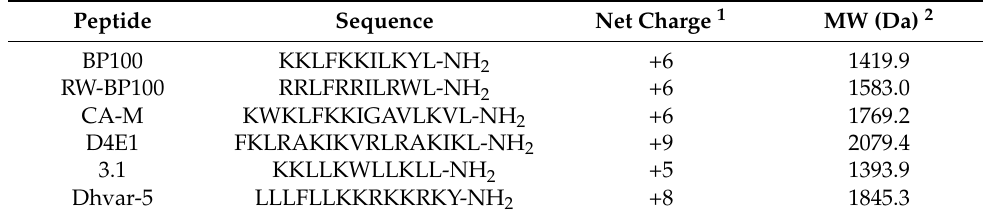
Table 1. Sequence and properties of peptides used in this work.